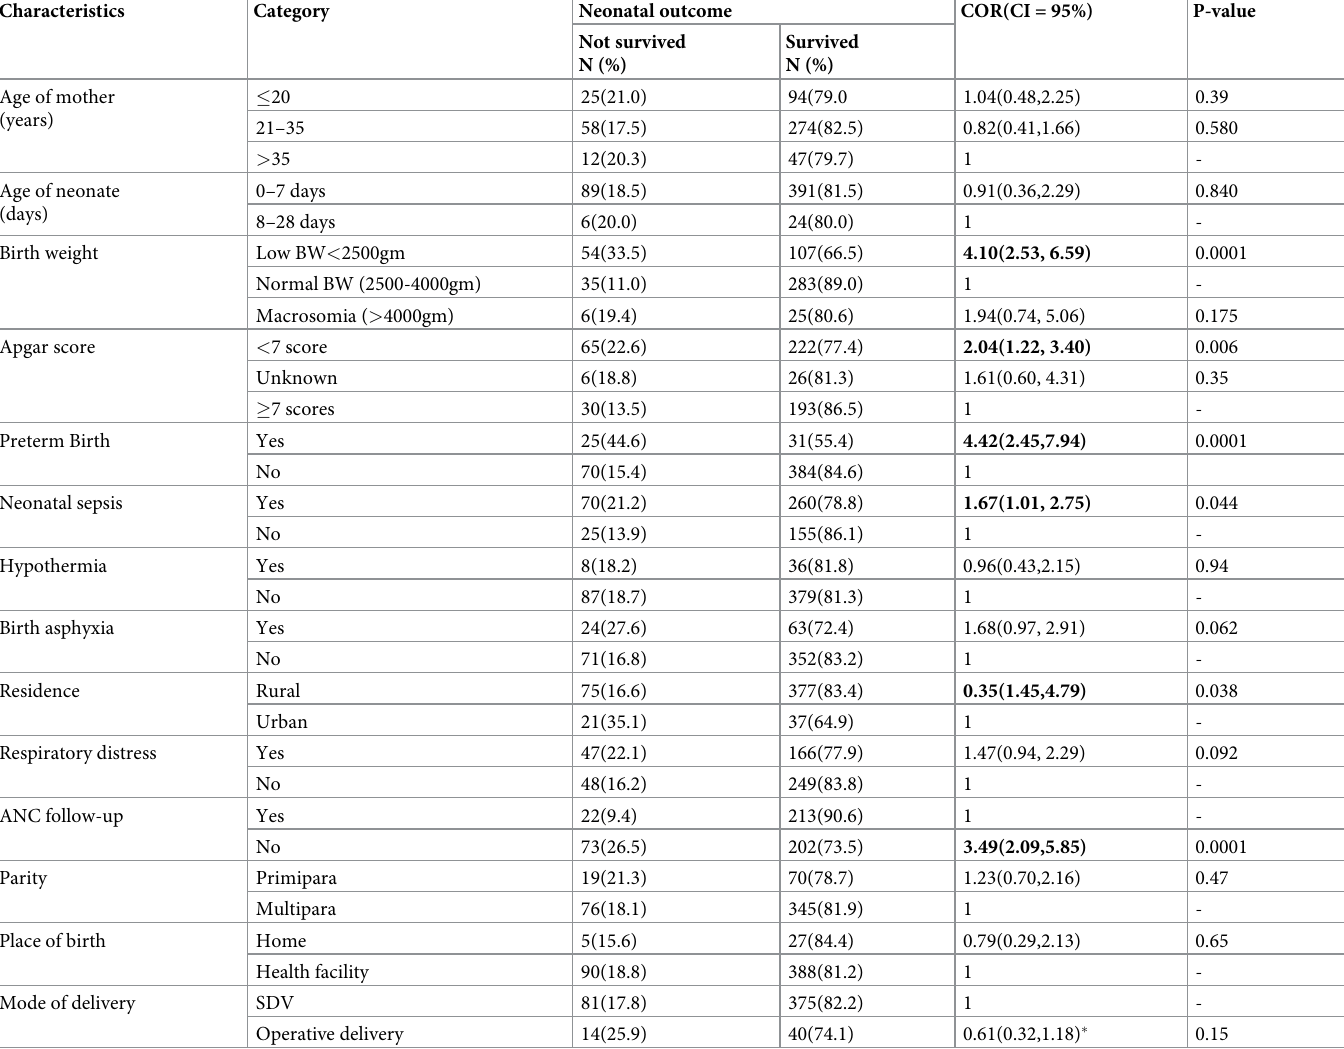
Table 3. Bi-variable logistic regression analysis of factors associated with neonatal mortality at selected public hospitals in Somali Regional State, Eastern Ethiopia, 2020.